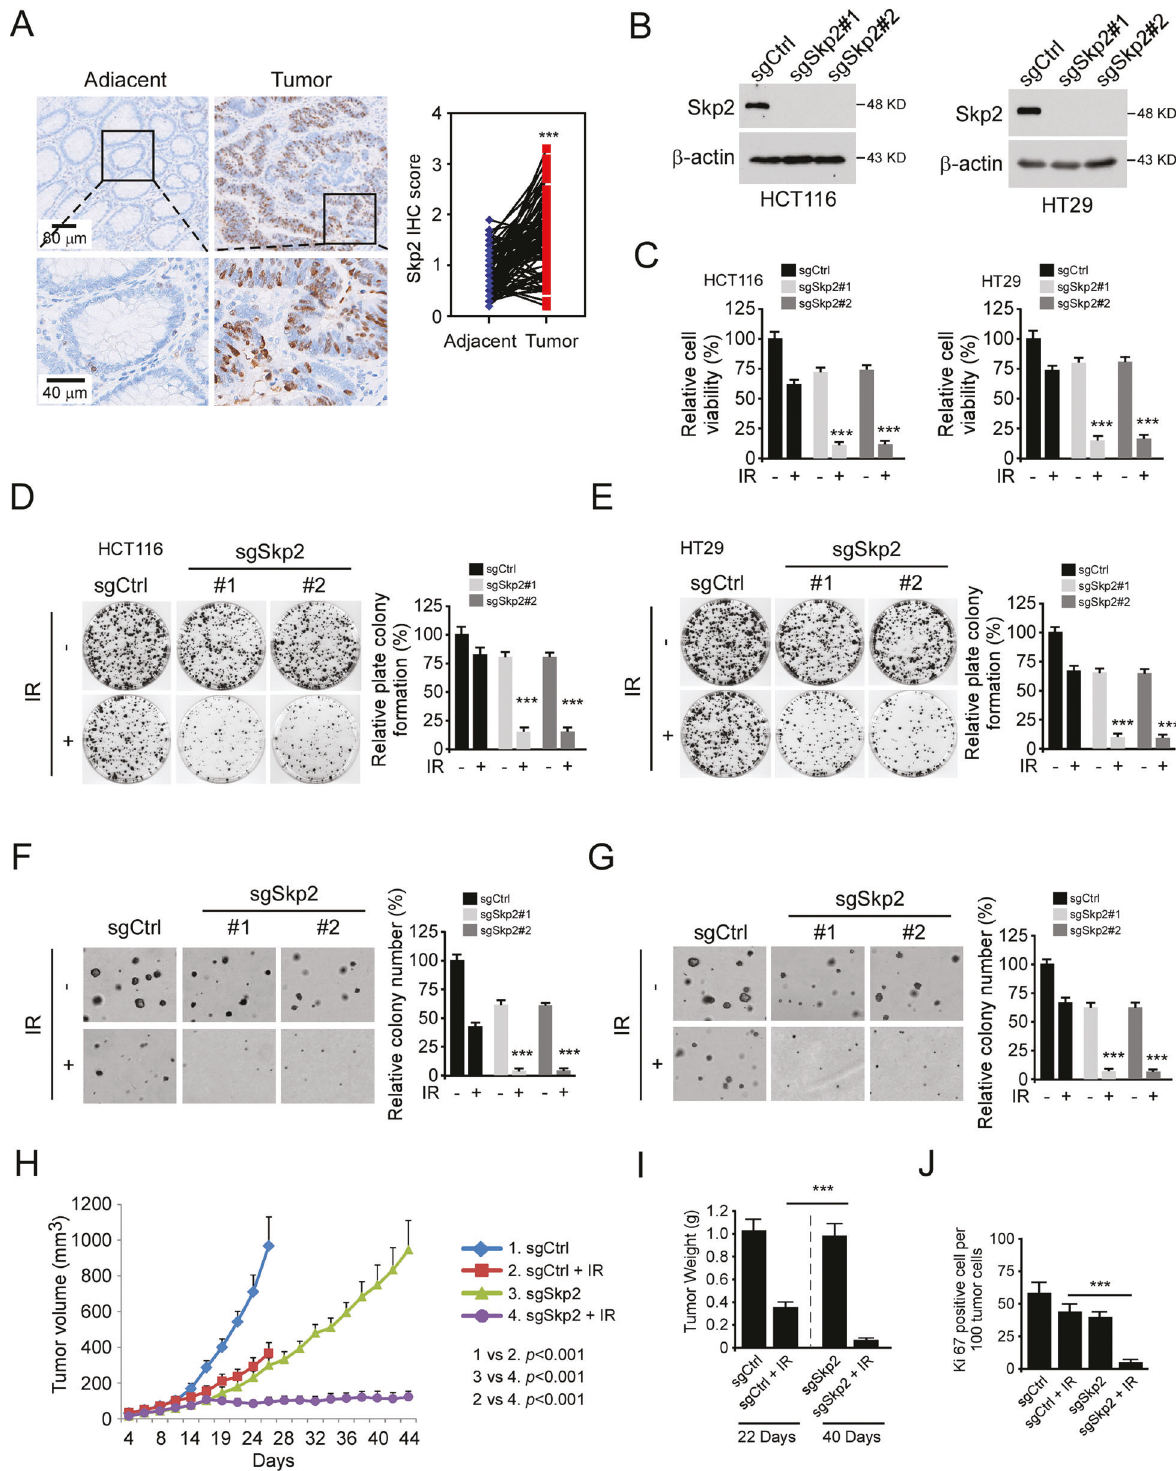
Fig. 1 Skp2 is required for the maintaining of tumorigenic properties of human colorectal cancer (CRC) cells. A Left, the representative staining images of CRC specimens and adjacent tissues; right, quanti fi cation of the staining intensity using Image-Pro PLUS (v.6) and Image J (NIH) computer software. *** p < 0.001. a signi fi cant difference between groups as indicated. B Immunoblot (IB) analysis of Skp2 protein level in Skp2 knock out CRC stable cell lines. C MTS assay was performed to determine the cell viability of Skp2 knock out CRC stable cell lines treated with/without 2 Gy irradiation (IR). *** p < 0.001. D , E Plate colony formation assay analysis of the colony formation of Skp2 knock out HCT116 ( D ) and HT29 ( E ) stable cell lines treated with/without IR (2 Gy). *** p < 0.001. F , G Soft agar assay determination of the anchorage-independent cell growth of Skp2 knock out HCT116 ( F ) and HT29 ( G ) stable cell lines treated with/without IR (2 Gy). *** p < 0.001. H – J Average tumor volume ( H ), average tumor weight ( I ), and the population of Ki67 positive cells ( J ) of HCT116-sgCtrl and HCT116-sgSkp2 xenografts treated with/ without IR. *** p < 0.001.